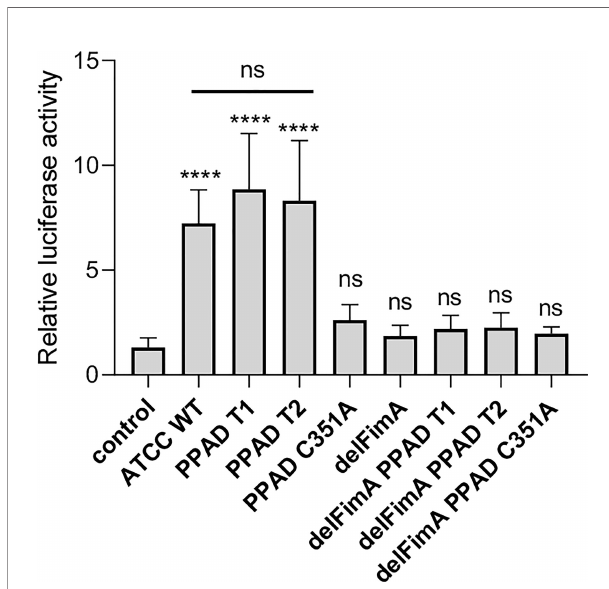
FIGURE 3 | Both active PPAD and fi mbriae are crucial for activation of TLR2. U251 MG cells overexpressing the TLR2 receptor were infected for 4 h (MOI=100) with various ATCC 33277-derived isogenic mutants expressing different forms of PPAD (the T1 form, the T2-hyperactive form, and the catalytically inactive C351A mutant form) or FimA; n=4. Results are presented as the mean ± SD ratio of Fire fl y luciferase activity to b -galactosidase activity and are normalized to cells stimulated/infected with the same factor and transfected with an empty vector. ****p < 0.0001; ns, no statistical signi fi cance; 1-way ANOVA followed by Tukey ’ s multiple comparisons